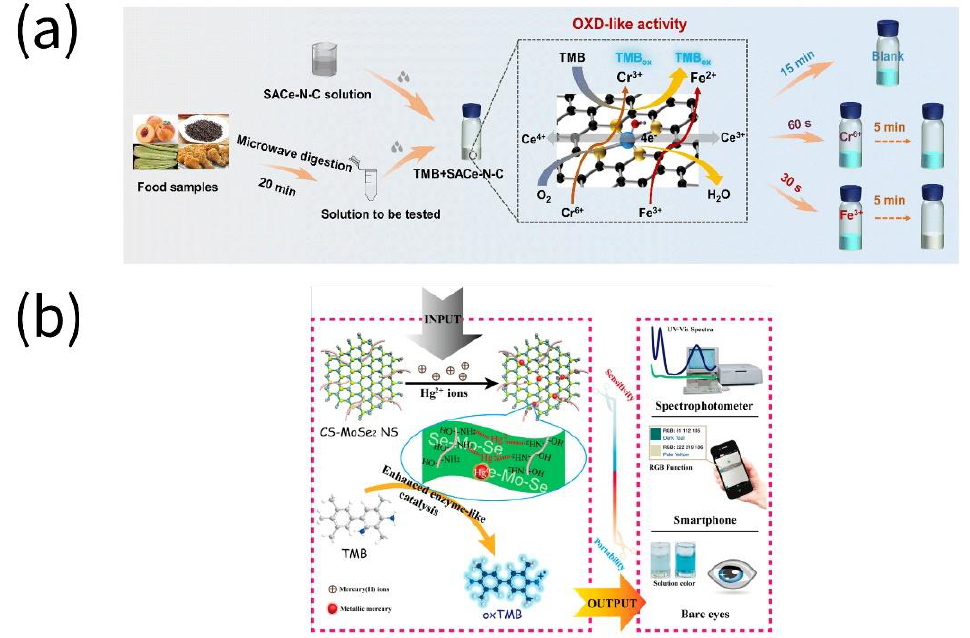
Figure 5. Assays for the detection of heavy metals in food by nanozymes. ( a ) Fe 3+ and Cr 6+ were detected using single-atom Ce-N-C (SACe-N-C) (reprinted with permission from [67], Copyright 2022, Elsevier). ( b ) Hg 2+ was detected using chitosan-functionalized molybdenum (IV) selenide nanosheets (CS-MoSe 2 NS) (reprinted with permission from [68], Copyright 2019, American Chemical Society).